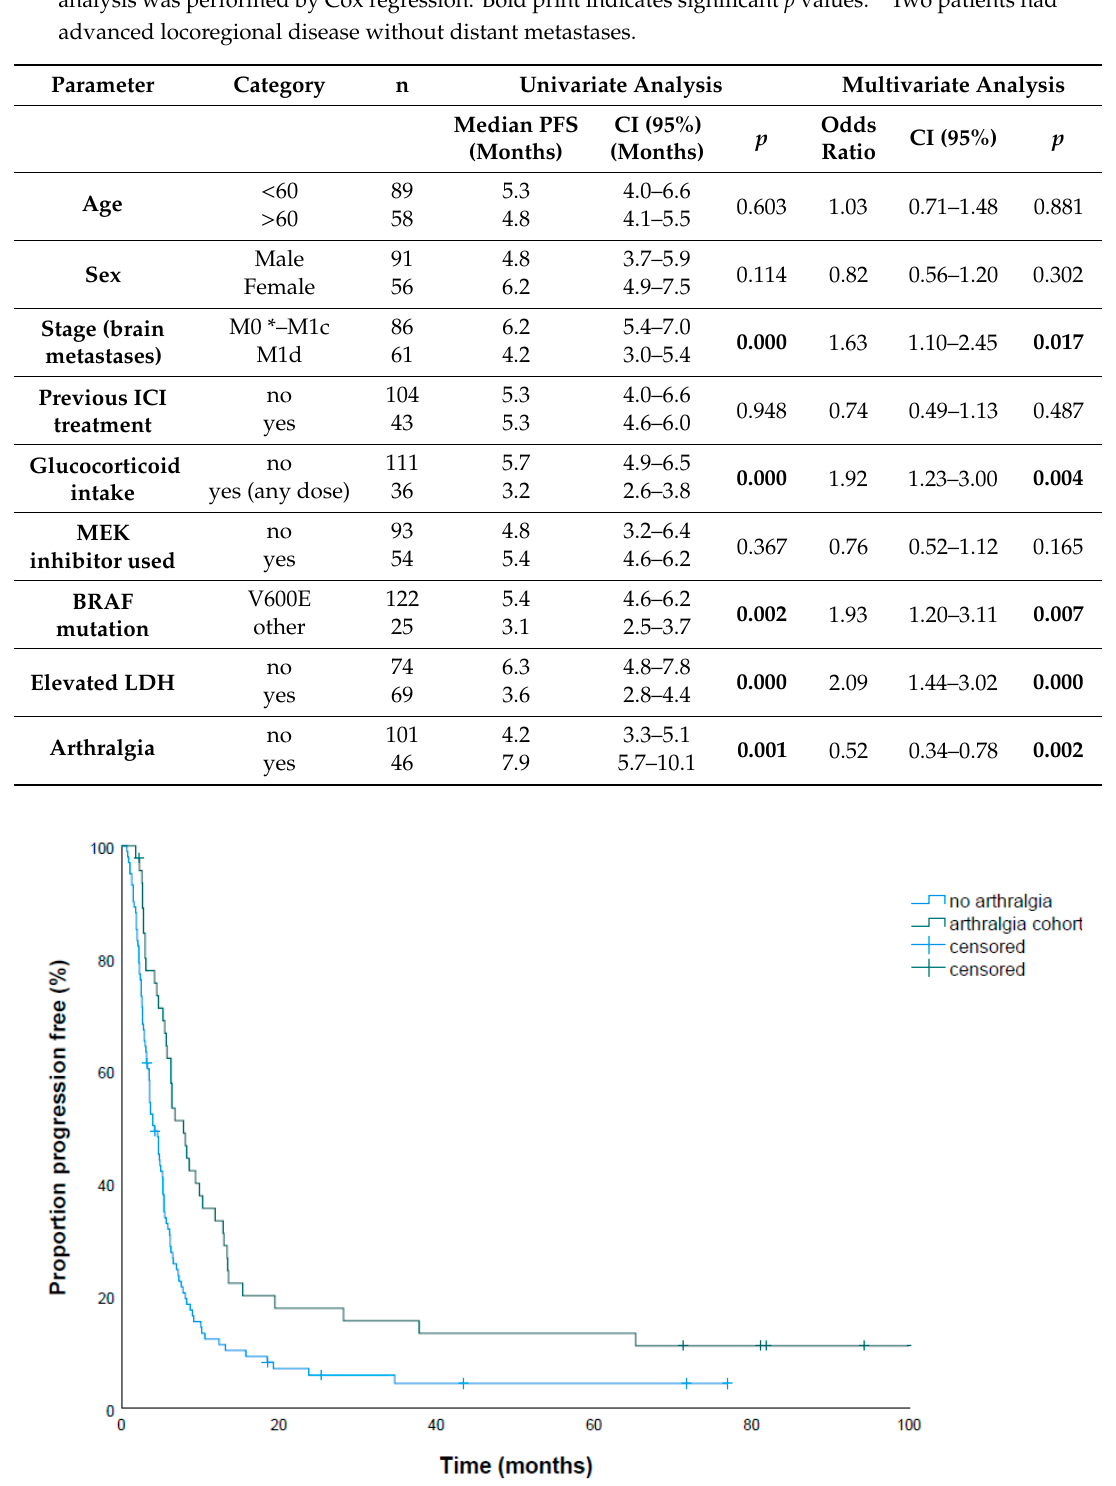
Figure 3. Kaplan–Meier estimated PFS shows improved PFS in patients with arthralgia (median 7.9 months (95% CI 5.7–10.1) vs. 4.2 months (95% CI 3.3–5.1 months), p = 0.001 (log rank)).